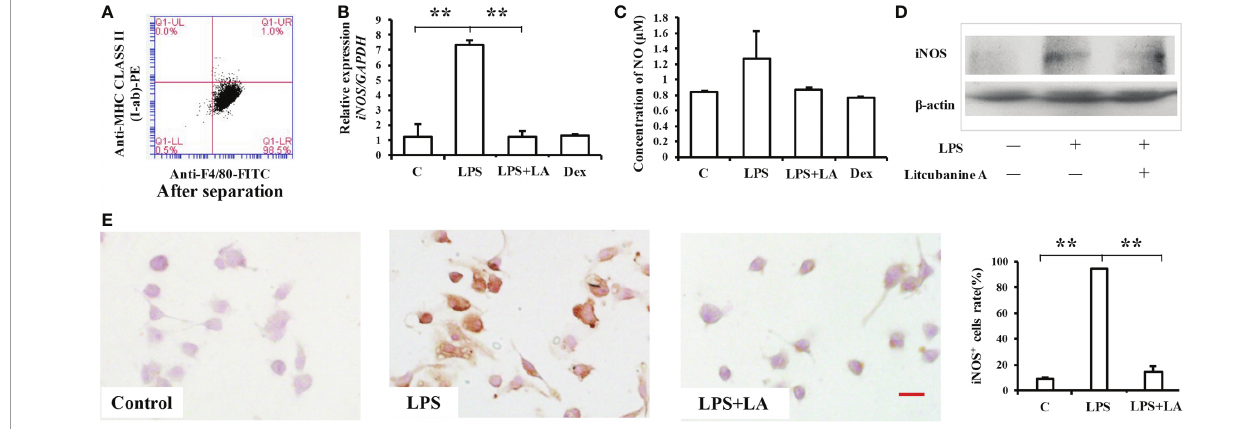
FIGURE 5 | Treatment with 100 nM LA inhibits the expression of LPS-induced iNOS in primary macrophages (A) Flow cytometric analysis showing that >98% of cells were macrophages after separation. (B) Real-time PCR analysis showing that treatment with LA decreases iNOS expression induced by LPS in peritoneal macrophages, and that the inhibitory effect was similar to that elicited by Dex (n=3). (C) LPS-induced NO expression was also inhibited by treatment with LA, which showed no signi fi cant difference compared with Dex (n=3). (D) Western blot analysis con fi rms that treatment with 100 nM LA decreases the protein expression level of total iNOS in peritoneal macrophages. (E) Immunocytochemical staining showing that the LPS-induced iNOS positive cell ratio signi fi cantly increased after LPS inducement (94.24% ± 0.60%) compared to the control group (9.35% ± 0.10%). However, treatment with 100 nM LA reduced the percentage of LPS-induced iNOS positive macrophages (14.36% ± 4.01%) (n=5). Scale bar = 20 m m. All results are representative of at least three independent experiments/samples. Results are expressed as means ± standard deviation (SD), and statistical signi fi cance is shown as **P <